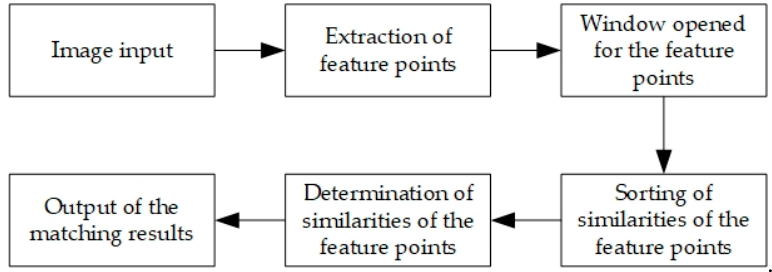
Figure 1. Flowchart of the Oriented FAST and Rotated BRIEF (ORB) matching algorithm based on spatial position constraint.